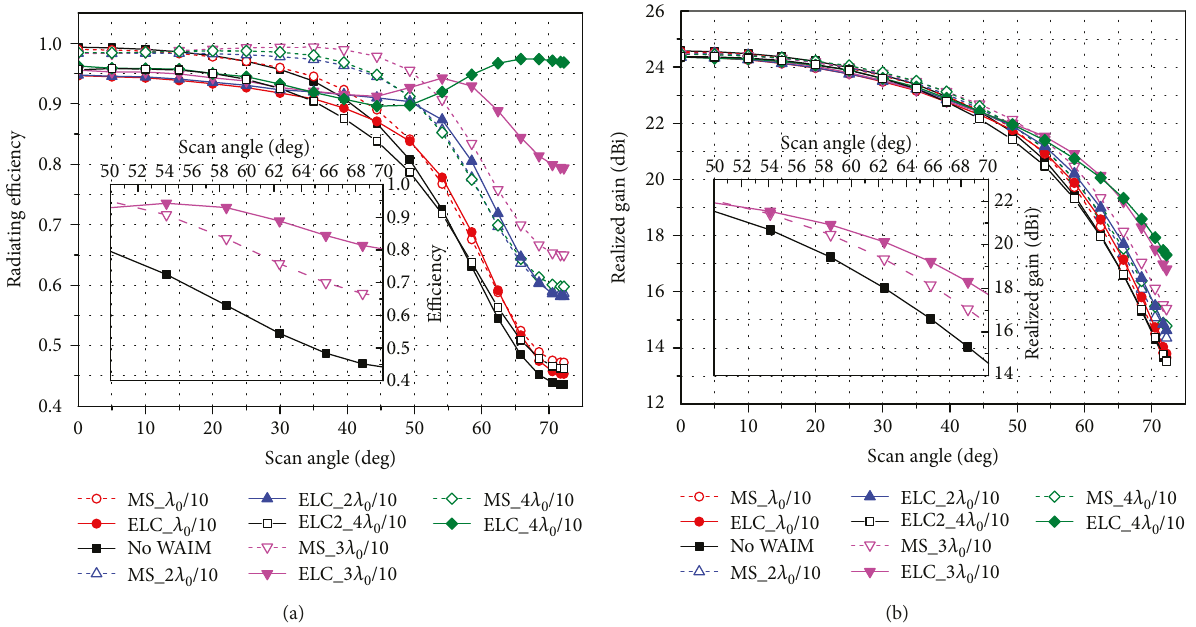
Figure 7: (a) Radiating e ffi ciency and (b) realized gains as a function of the scan angle at 10.0GHz in the E -plane for the four